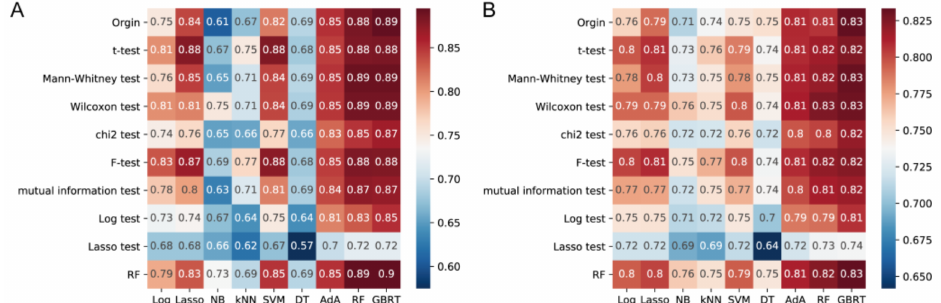
Figure 7. Cross-validated area-under-the-curve values ( A ) and predictive performance of 90 models on test ( B ) datasets. Abbreviations: kNN, k-Nearest Neighbors; SVM, Support vector machine; DT, Decision tree; RF, Random forest; AdA, AdaBoost; NB, Naïve Bayes; GBRT, Gradient tree boosting tree; Log,